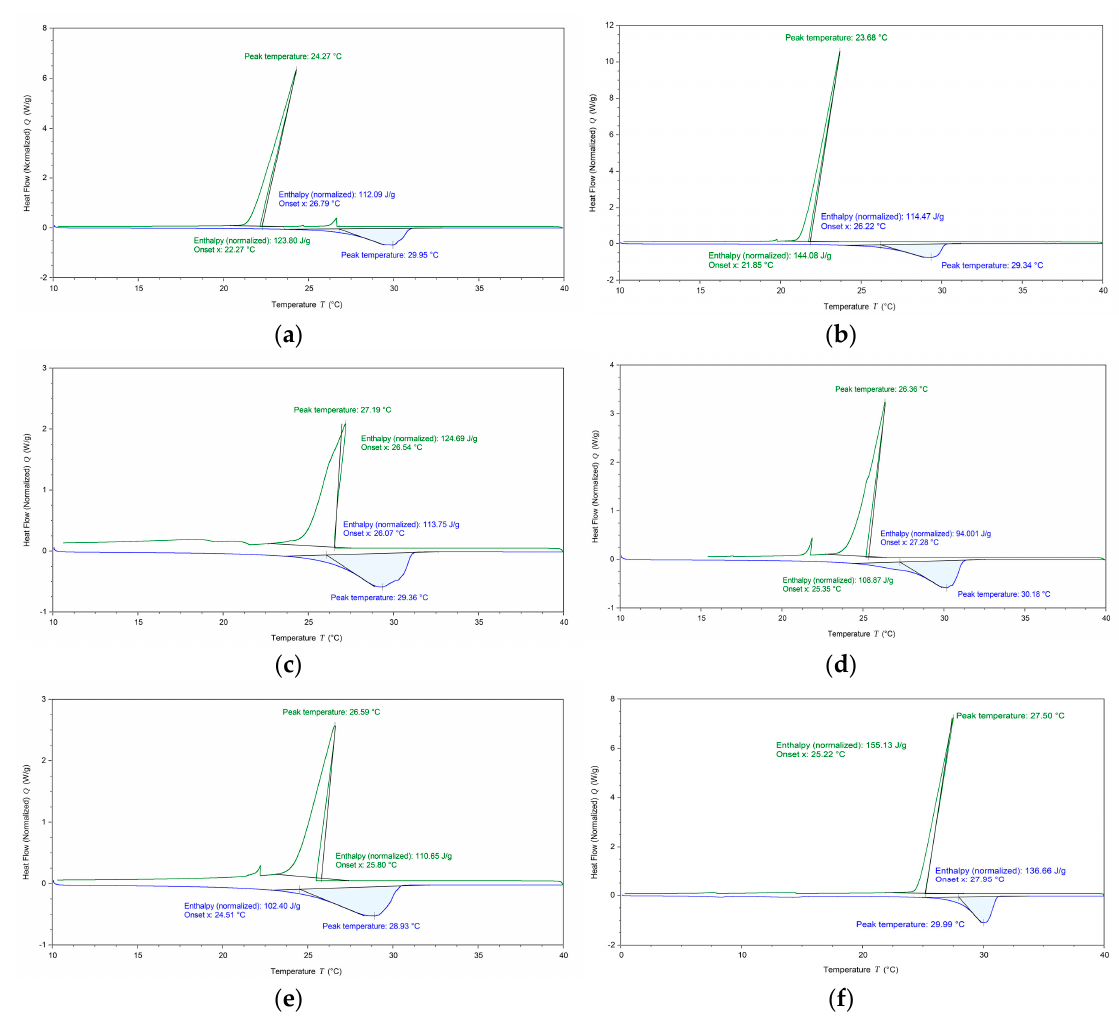
Figure 3. DSC test curves of different DE mass fractions ( a ) 3%; ( b ) 4%; ( c ) 5%; ( d ) 6%; ( e ) 7%; ( f ) 4.87%.